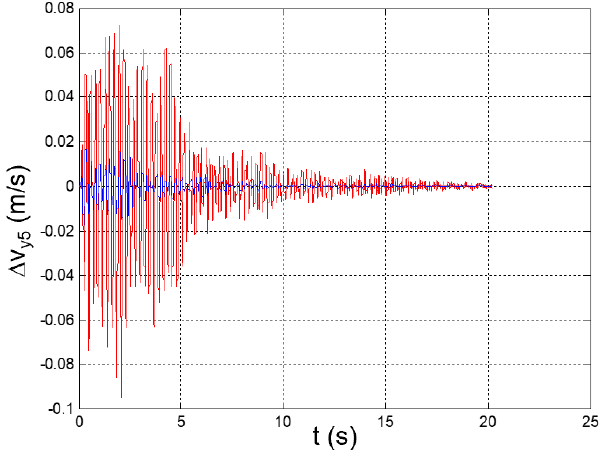
Figure 40. Seismic response, interstory speed at the 5th floor ( ∆ v y5 = v y5 − v y4 ). Peak values of the plotted parameters are recapped in Table 5, together with the achieved mitigation coefficients. Table 5. Seismic response of the reference structure, peak values of the relevant parameters, and mitigation coefficients.